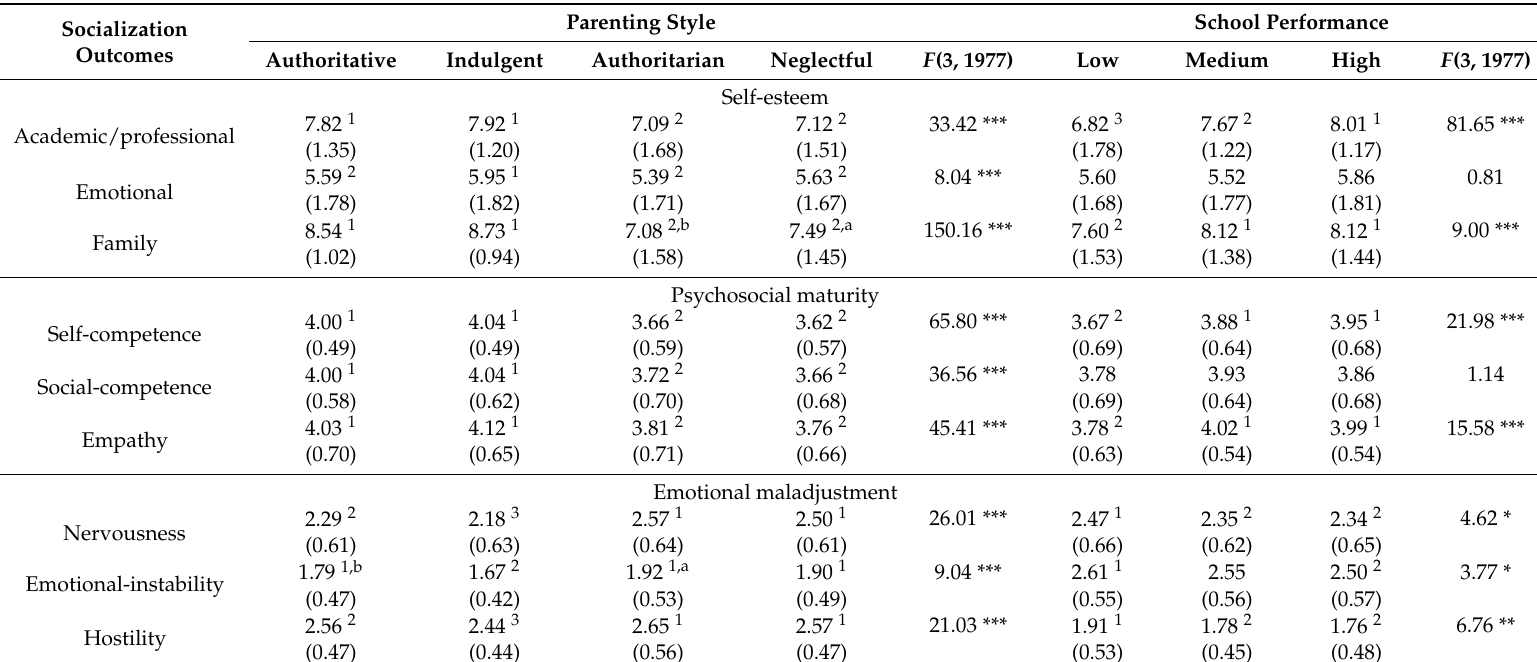
Table 3. Means (and standard deviations) for parenting style and school performance, and main univariate F values for the set of outcome measures (self-esteem, psychosocial maturity, and emotional